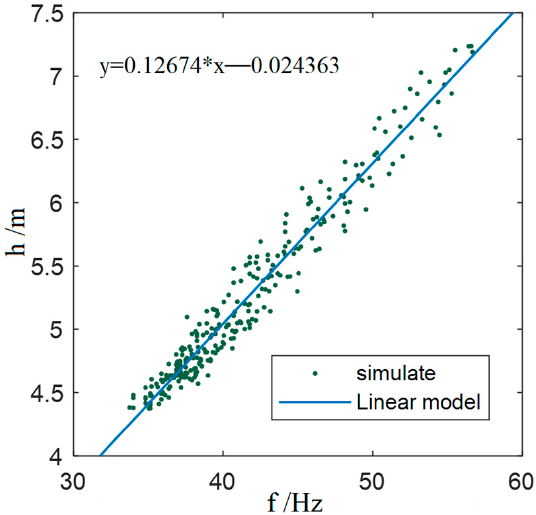
Figure 5. The linear relationship diagram between the antenna phase center and the peak frequency of the Lomb–Scargle spectrum analysis. The longitudinal ordinate h represents the height from the antenna phase center to the reflective surface; the horizontal ordinate f represents the peak frequency corresponding to the Lomb–Scargle spectrum.